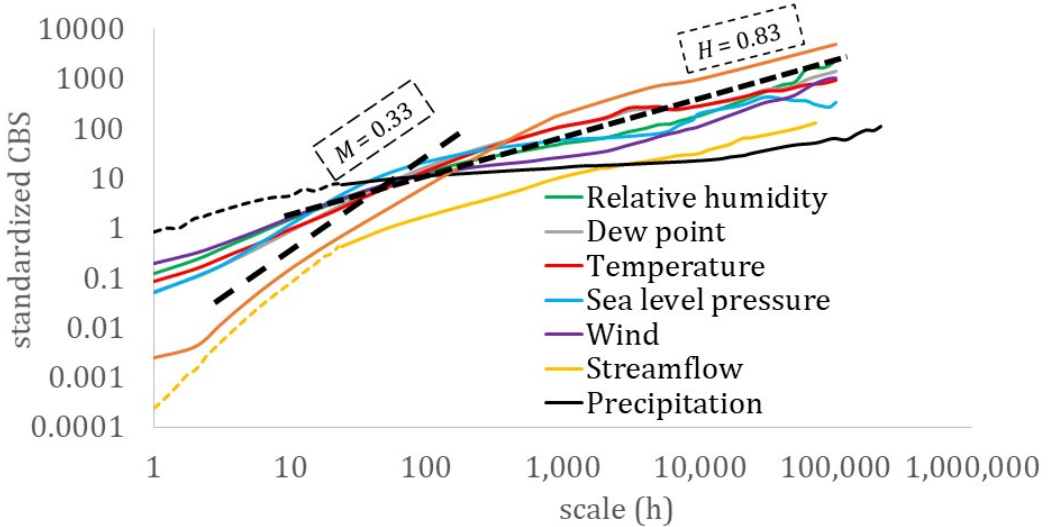
Figure 12. The mean climacogram for the key hydrological-cycle processes and the grid-turbulence process accustomed for illustration to a 25 μ s-scale rather than to the hourly-scale. Dashed and continuous lines at streamflow and precipitation correspond to the hourly and daily stations.